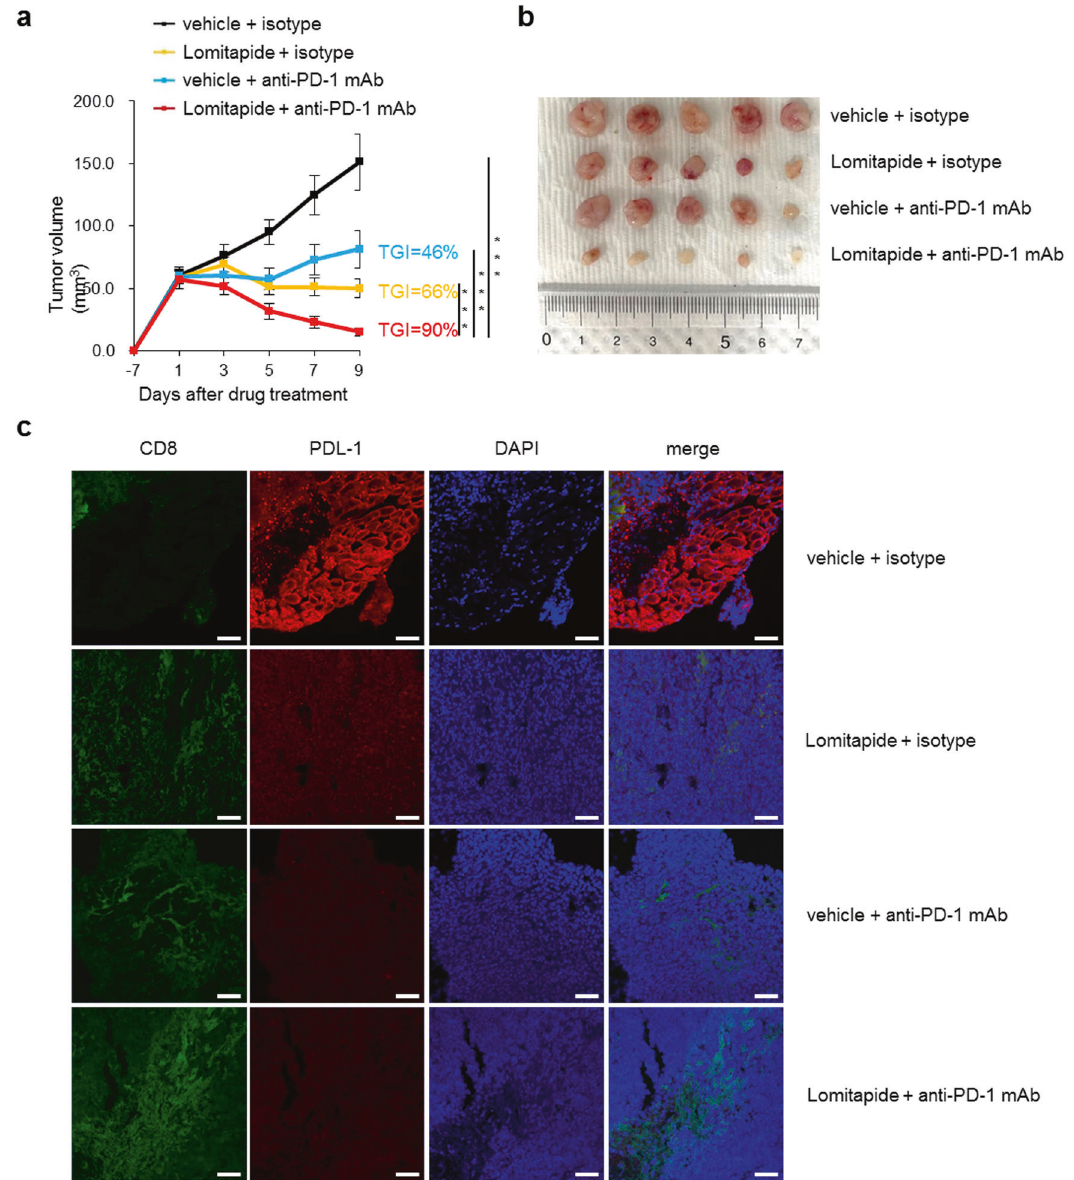
Fig. 6 Treatment of tumor-bearing mice with lomitapide improves the therapeutic bene fi t of anti-PD-1 immunotherapy. a Tumor growth curves of MC38 mouse colon cancer cells in mice treated with control (vehicle) or lomitapide combined with either control isotype or anti-PD- 1. Lomitapide at 20 mg/kg every day, anti-PD-1 or isotype IgG 10 mg/kg every other day. Statistically signi fi cant differences (indicated by asterisks) are calculated using an unpaired two-tailed Student ’ s t -test (* P < 0.05, ** P < 0.005, and *** P < 0.0005). b Representative images of tumor tissues at 18 days following inoculation of MC38 cells. c Representative results of immuno fl uorescence staining of CD8 (green), PD-L1 (red), and DAPI (blue) in MC38 tumor tissues. Scale bar: 20 μ